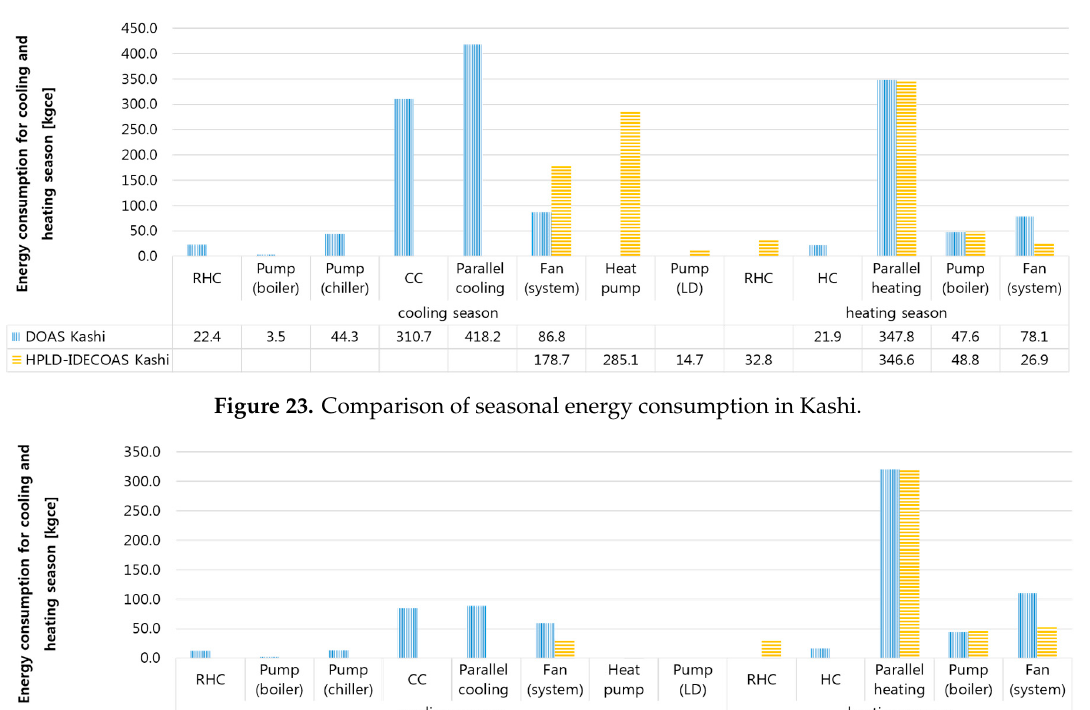
Figure 24. Comparison of seasonal energy consumption in Lhasa.